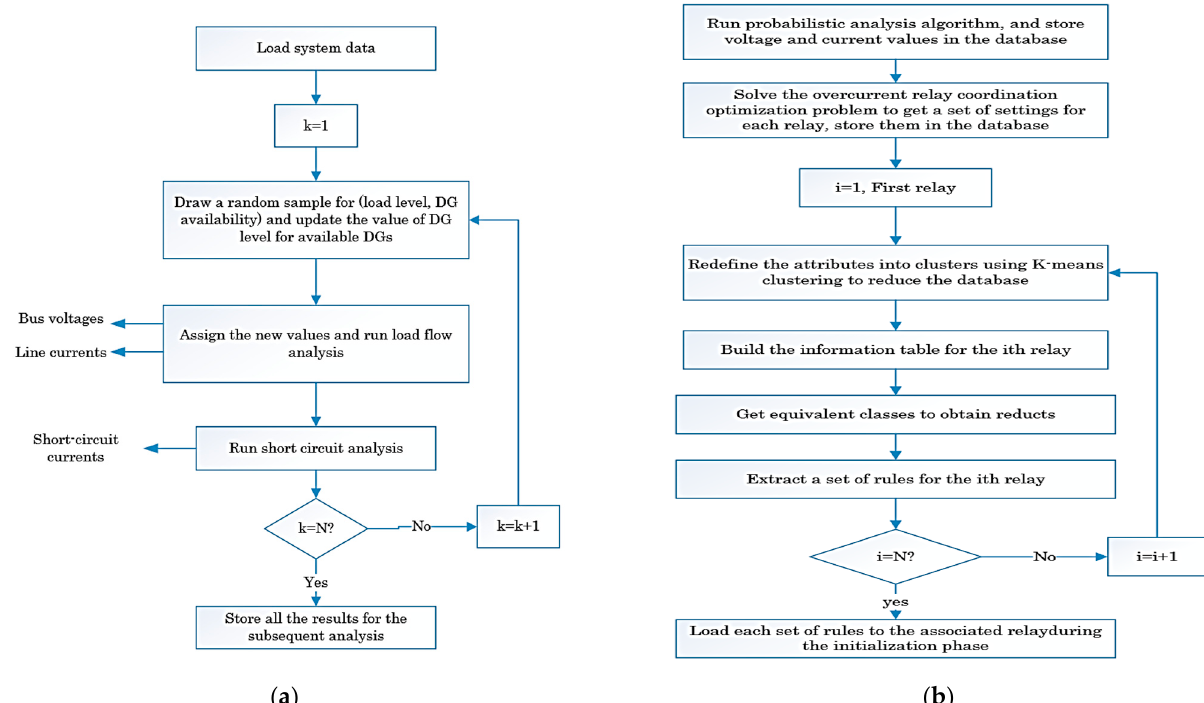
Figure 3. ( a ) Probabilistic analysis algorithm; ( b ) cyber attack detection—offline phase.